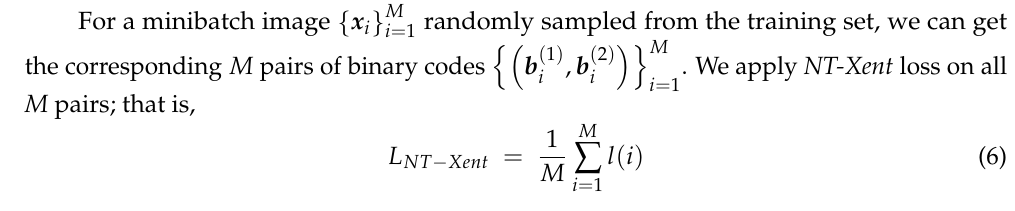
Figure 3. Rectified linear units (ReLU) function and continuation optimization. ( a ) ReLU function. ( b ) Continuation